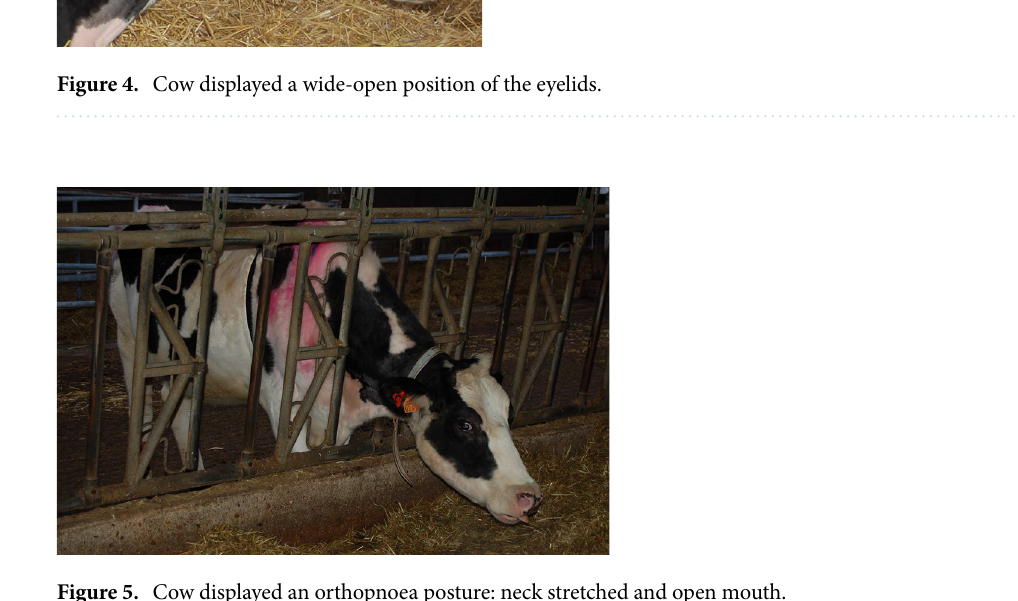
Figure 5. Cow displayed an orthopnoea posture: neck stretched and open